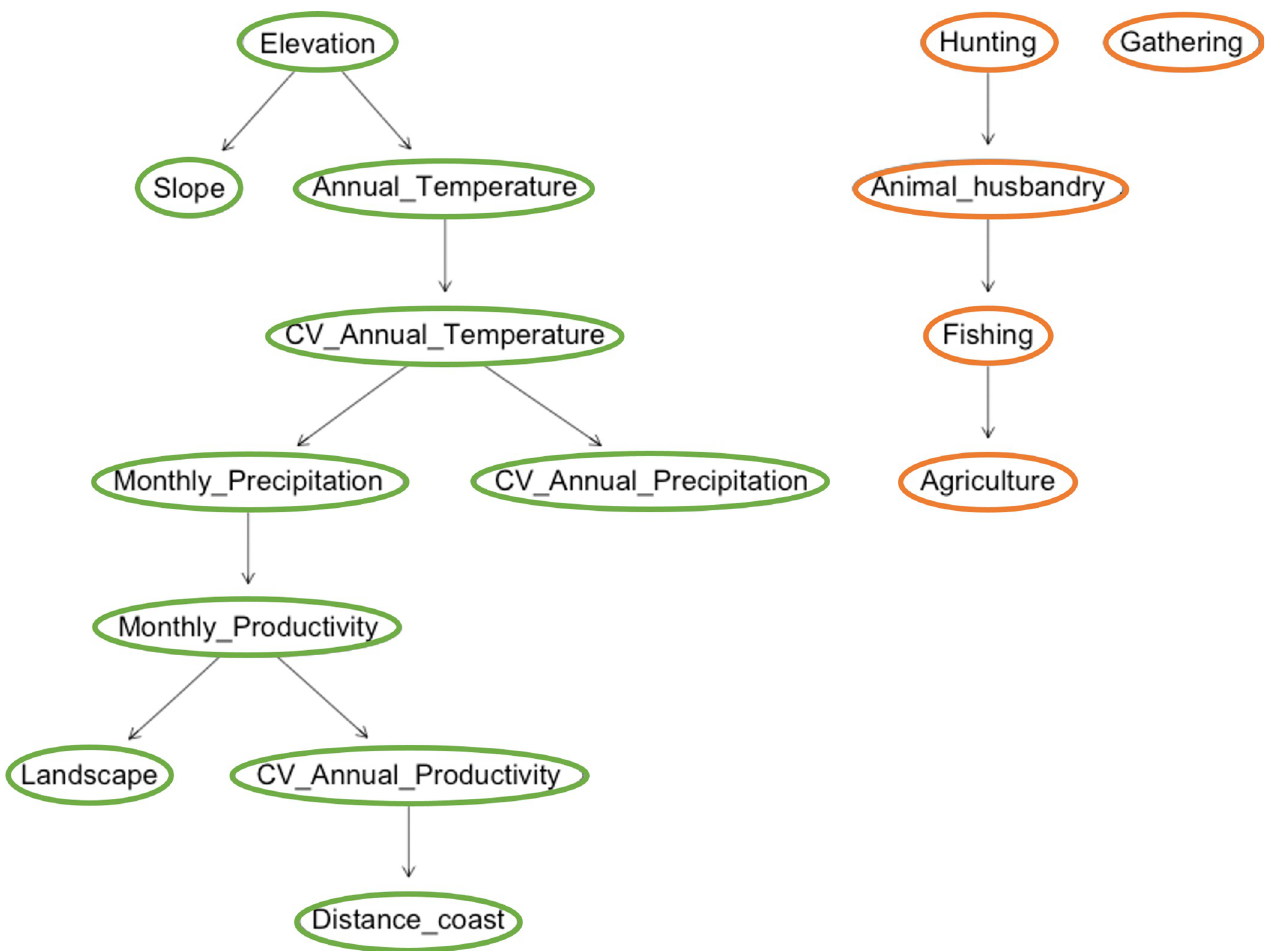
Fig 5. Final Model B exploring the influence of the environment on subsistence strategies. In this scenario we predicted the correlations among the ecological characteristics (inputs, green) and the subsistence strategies (outputs, orange).